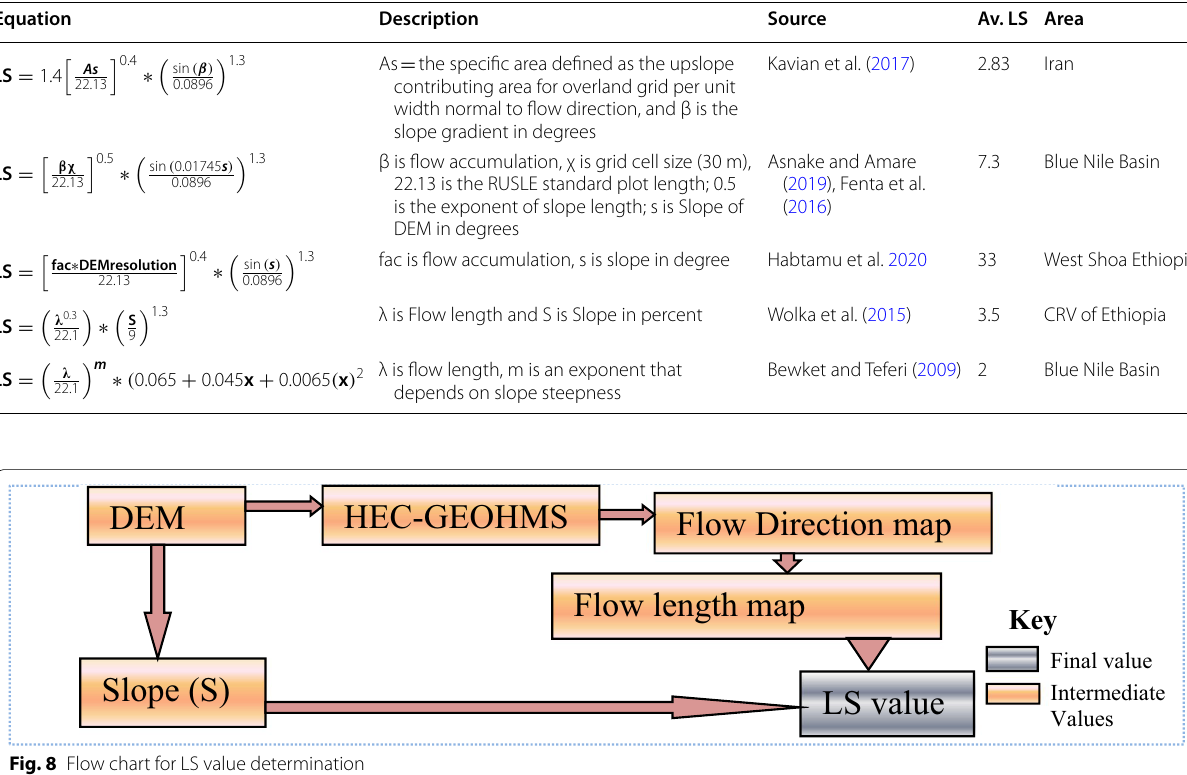
Table 4 Table of topographic factors formula for different studies Equation